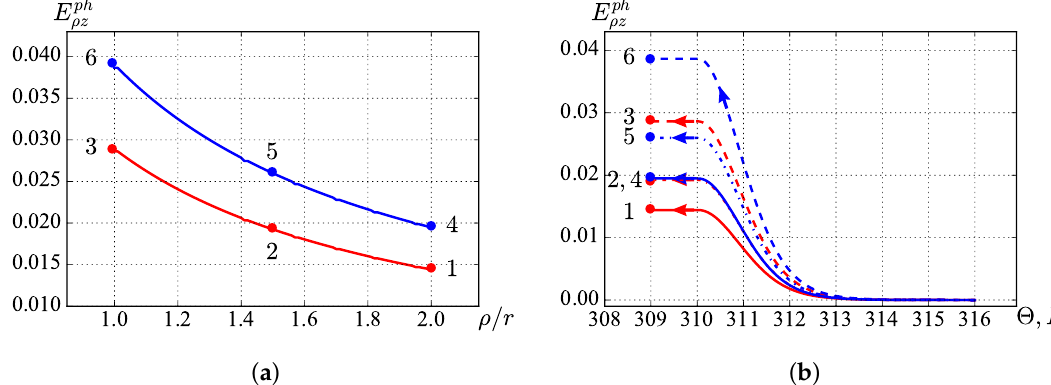
Figure 6. Phase strains: distribution along the radius ( a ) and dependence on temperature ( b